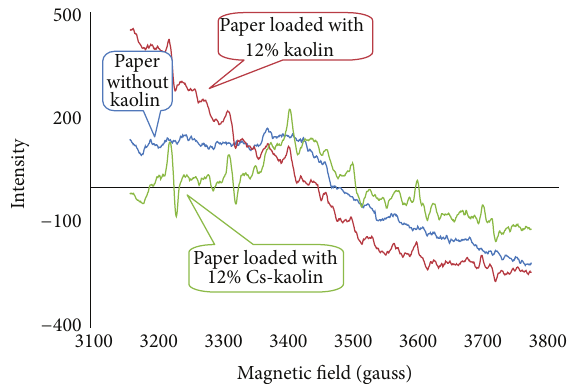
Figure 6: ESR spectra for nonirradiated wood paper handsheets (without kaolin, 12% kaolin, and 12% Cs-kaolin).